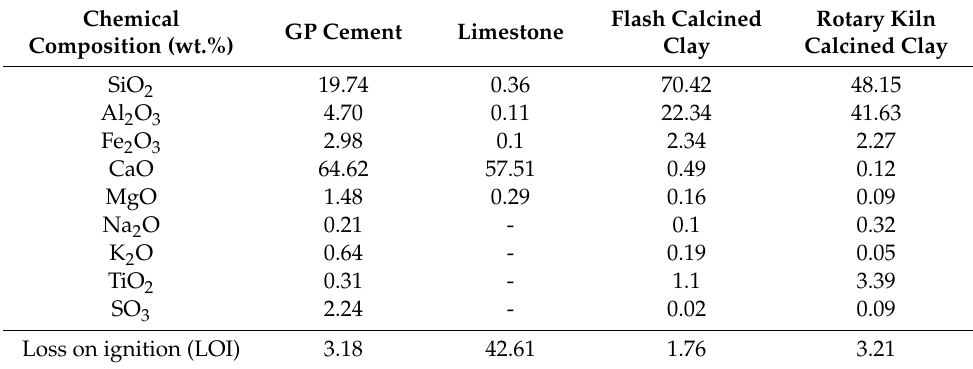
Table 1. Chemical compositions of binder. GP cement: general purpose